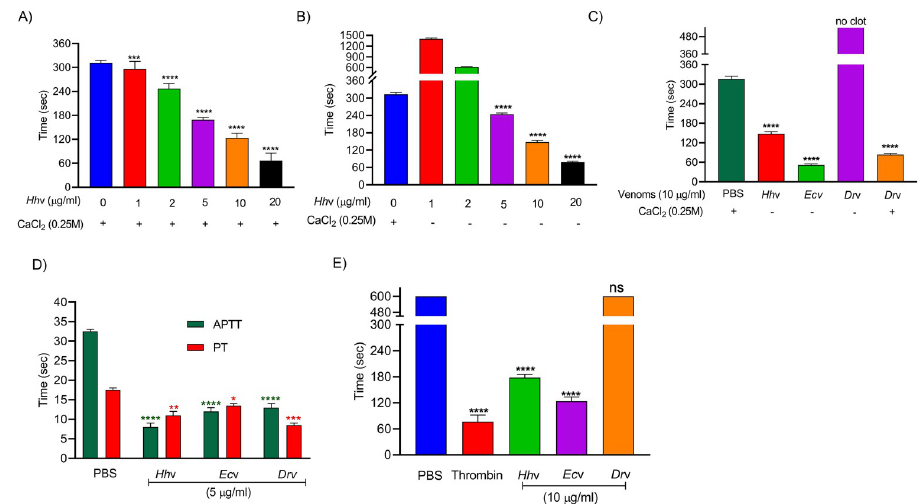
Fig 4. Effect of H . hypnale , E . carinatus , and D . russelii venoms on coagulant activities. (A) Plasma re-calcification time of Hh v; 200 μ l of citrated human plasma was treated with 1–20 μ g/ml of venom for 1 min at 37 0 C, clotting was initiated by adding 20 μ l 0.25 M CaCl 2. (B) Hh v induced the plasma coagulation in the absence of CaCl 2 ; clotting was initiated by adding 1–20 μ g/ml of Hh v to the 200 μ l of citrated human plasma. (C) Comparative plasma re-calcification time of Hh v, Ec v, and Dr v; 200 μ l of citrated human plasma was independently treated with 10 μ g/ml each of venoms to initiate the clotting. For Dr v, clotting was initiated separately by adding 20 μ l 0.25 M CaCl 2 . (D) Activated partial thromboplastin time (APTT); 100 μ l of citrated human plasma was treated independently with 5 μ g/ml each of Hh v, Ec v, and Dr v for 1 min at 37 0 C, then 100 μ l of reagent (LIQUICELIN-E phospholipids preparation derived from rabbit brain with ellagic acid) was added and incubated for 3 min at 37 0 C. The clotting was initiated by adding 100 μ l 0.02 M CaCl 2 . Prothrombin time (PT); 100 μ l of citrated human plasma was treated independently with 5 μ g/ml each of Hh v, Ec v, and Dr v for 1 min at 37 0 C. The clotting was initiated by adding 100 μ l of PT reagent (UNIPLASTIN– rabbit brain thromboplastin). In all the cases, the plasma devoid of venom was served as control experiments. (E) Thrombin clotting time (TCT); 100 μ l of fibrinogen (3 mg/ml) in 10 mM Tris-HCl buffer pH 7.6 was independently treated with 10 μ g/ml each of Hh v, Ec v, and Dr v to initiate the clotting. Thrombin, 10 U was used as a positive control, and fibrinogen alone was served as a negative control. In all the above experiments, the time taken for the visible clot formation was recorded in seconds. In all the cases, the data is presented as Mean ± SEM (n = 4) and analyzed using one-way/two-way ANOVA followed by Bonferroni post-tests, ‘ ���� p < 0.0001, ��� p < 0.001, �� p < 0.01, � p < 0.05, and ns (not significant) > 0.05. ‘ � ’ significant compared to the control group